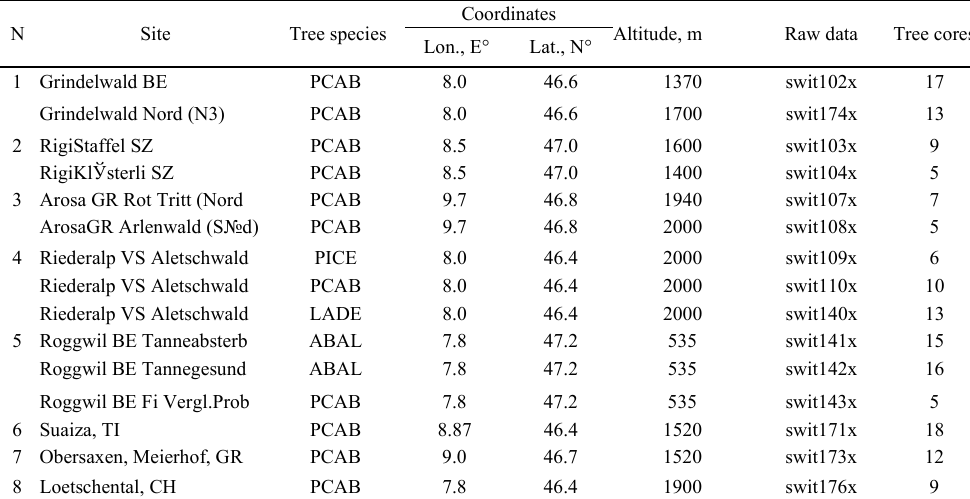
Table 1: Data on the wood density measurements